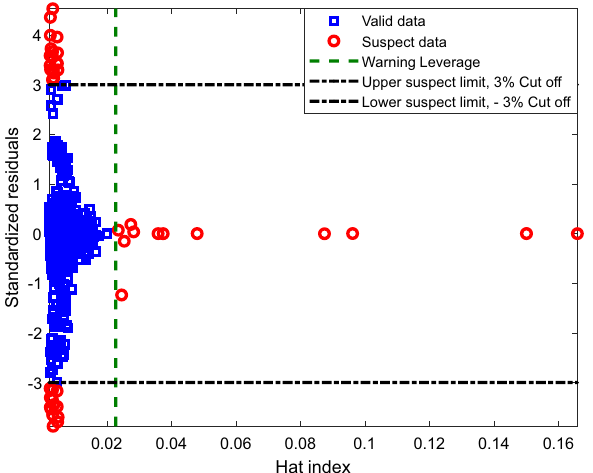
Figure 13. Outlier/valid data detection by the Leverage